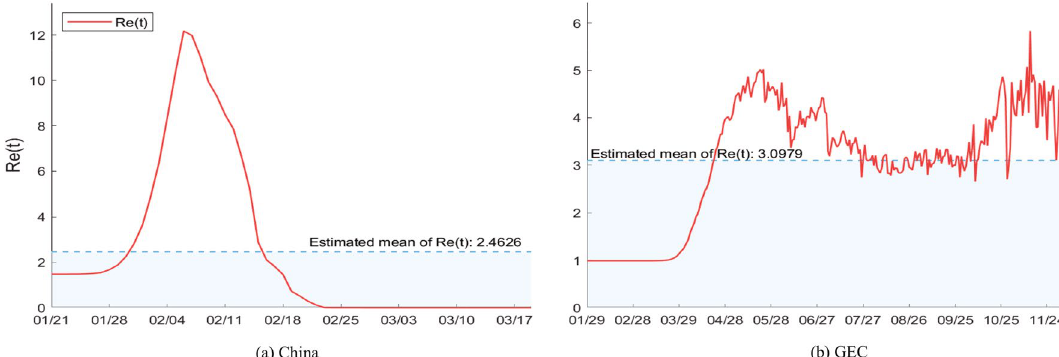
Figure 3. Estimation results for the effective reproductive number.